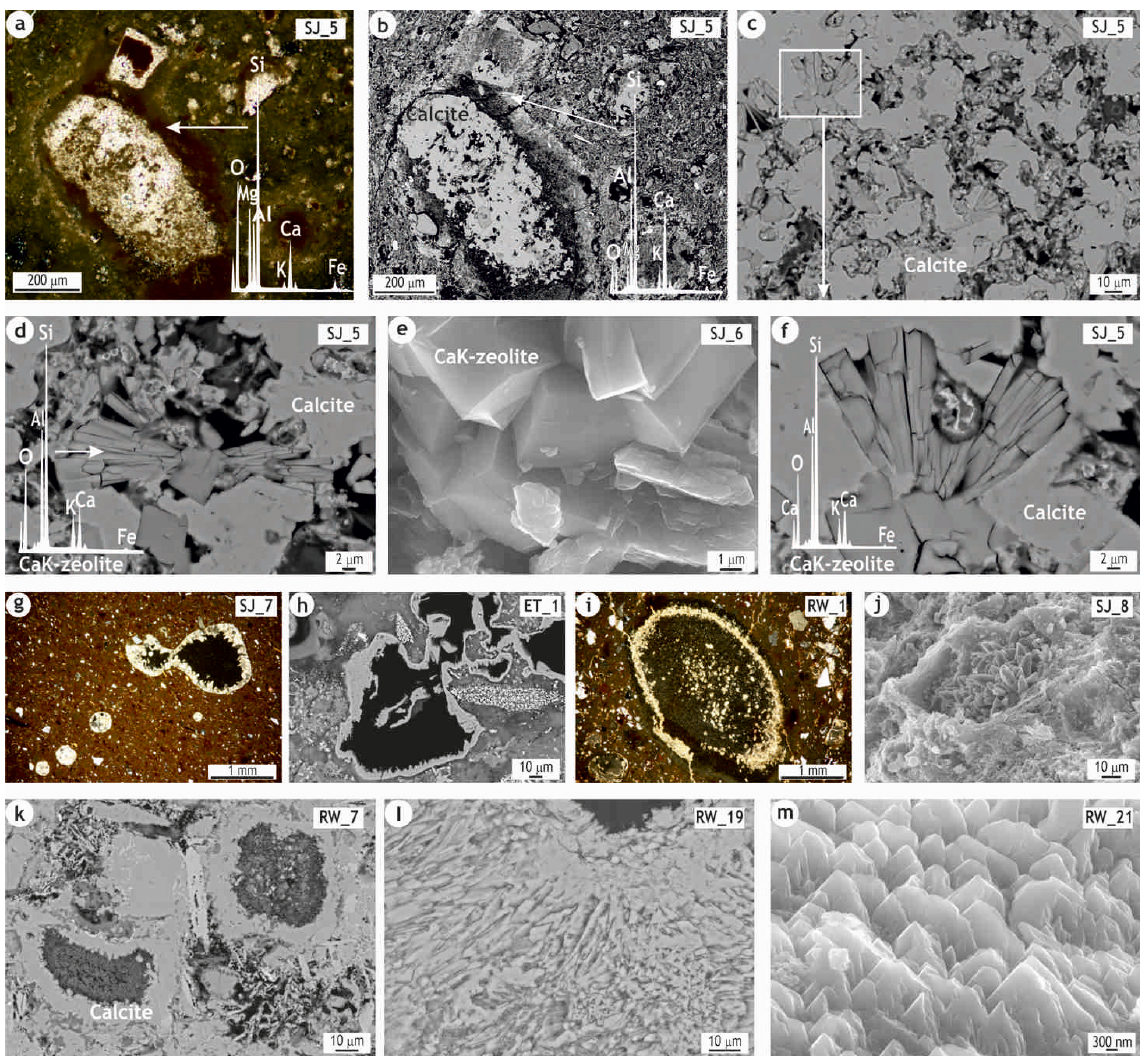
Figure 5. POM and HRSEM BSE/SE images and some EDS spectra on secondary zeolite and calcite. (a, b) Coarse calcite grain with dark corona-like microstructure observed by POM and HRSEM and EDS spectra of the first-stage (dark, a ) and second-stage (light, b ) reaction domains; (c) zeolite crystals formed within the more altered areas of the coarse calcite grains; (d, e, f) detailed images of the cubic and fan-shaped CaK-zeolite crystals, probably corresponding to phillipsite-K; (g, h) needle-shaped crystals of precipitated calcite partially filling the pores (sample belonging to CHCB 1 ); (i, j) precipitated calcite crystals filling shrinkage rims (sample belonging to CHCB 1 ) and/or grown over a slightly decomposed carbonate grain; (k) smooth precipitated calcite filling shrinkage rims; (l, m) scalenohedral crystals of calcite – dogtooth growth – preferably oriented in line with the c